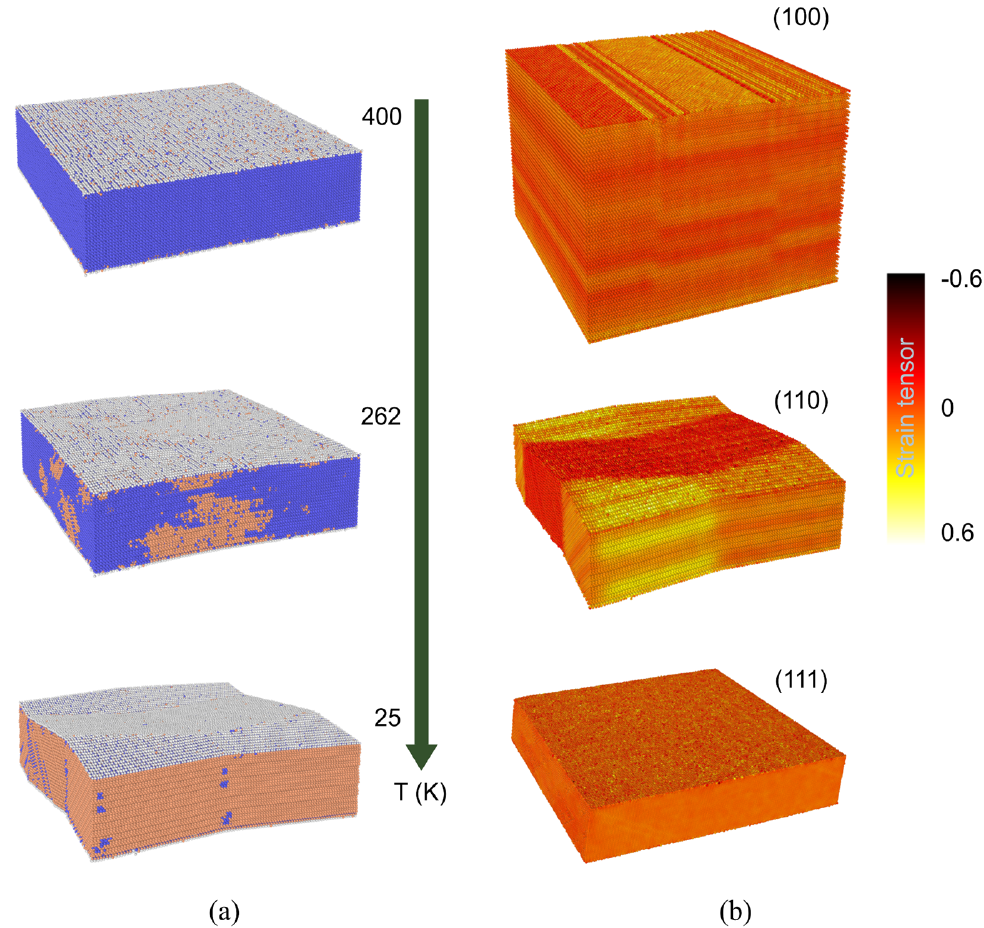
Figure 4. ( a ) The martensitic transition of the TiNi wafers through (110) direction and thickness is 25 nm. Blue color corresponds to the austenite and orange color to martensite. ( b ) The strain tensor (sum of non-diagonal elements) of the TiNi wafers through (100), (110), and (111) directions.